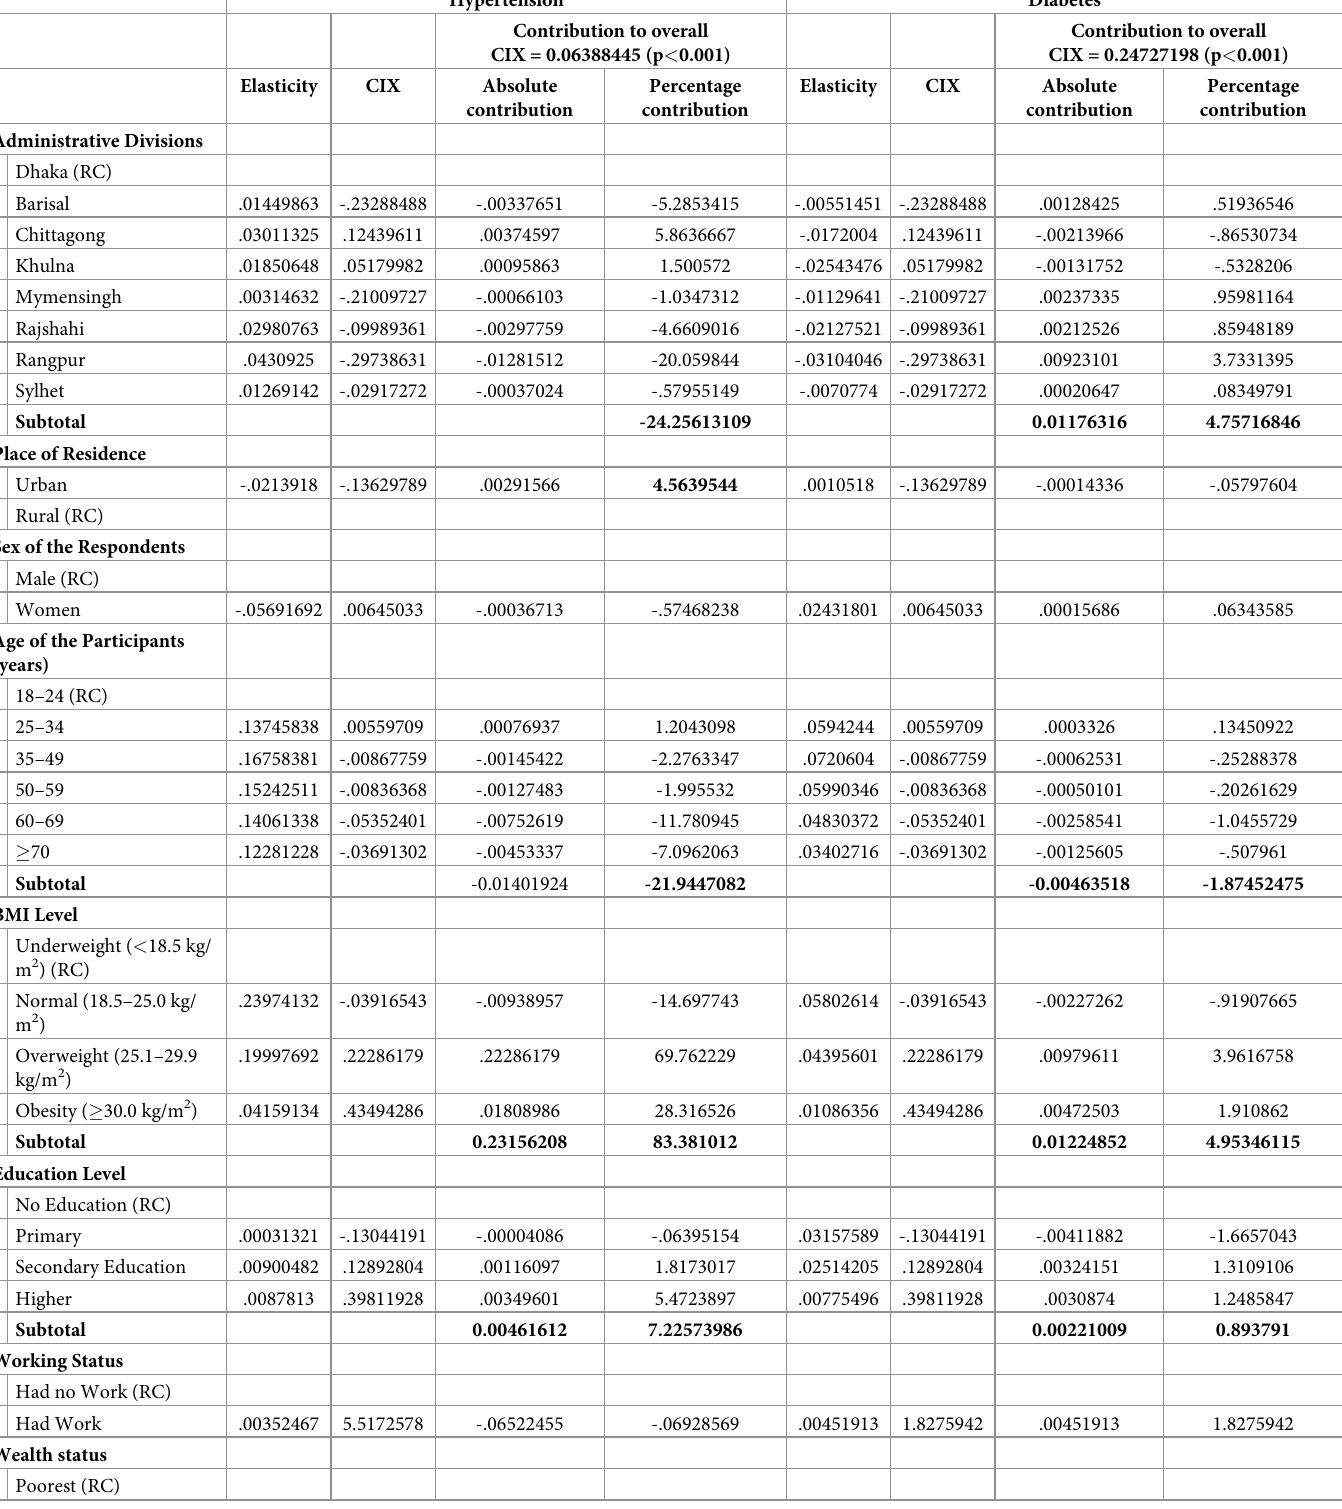
Table 4. Decomposition of concentration index for measuring socioeconomic inequalities in hypertension and